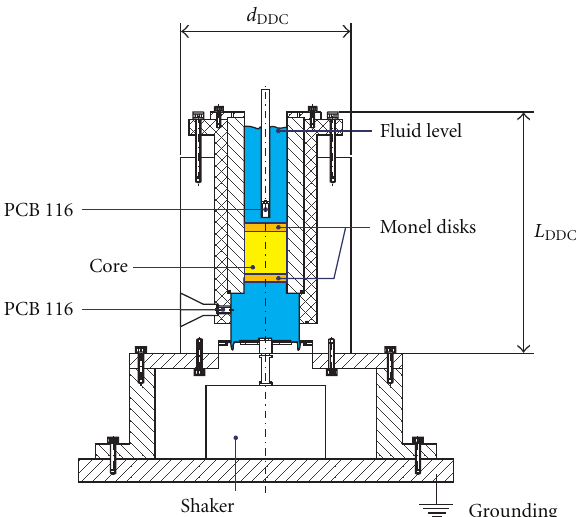
Figure 3: Schematic of the dynamic Darcy cell with borosilicate sample and Monel disks (modified from [27]).